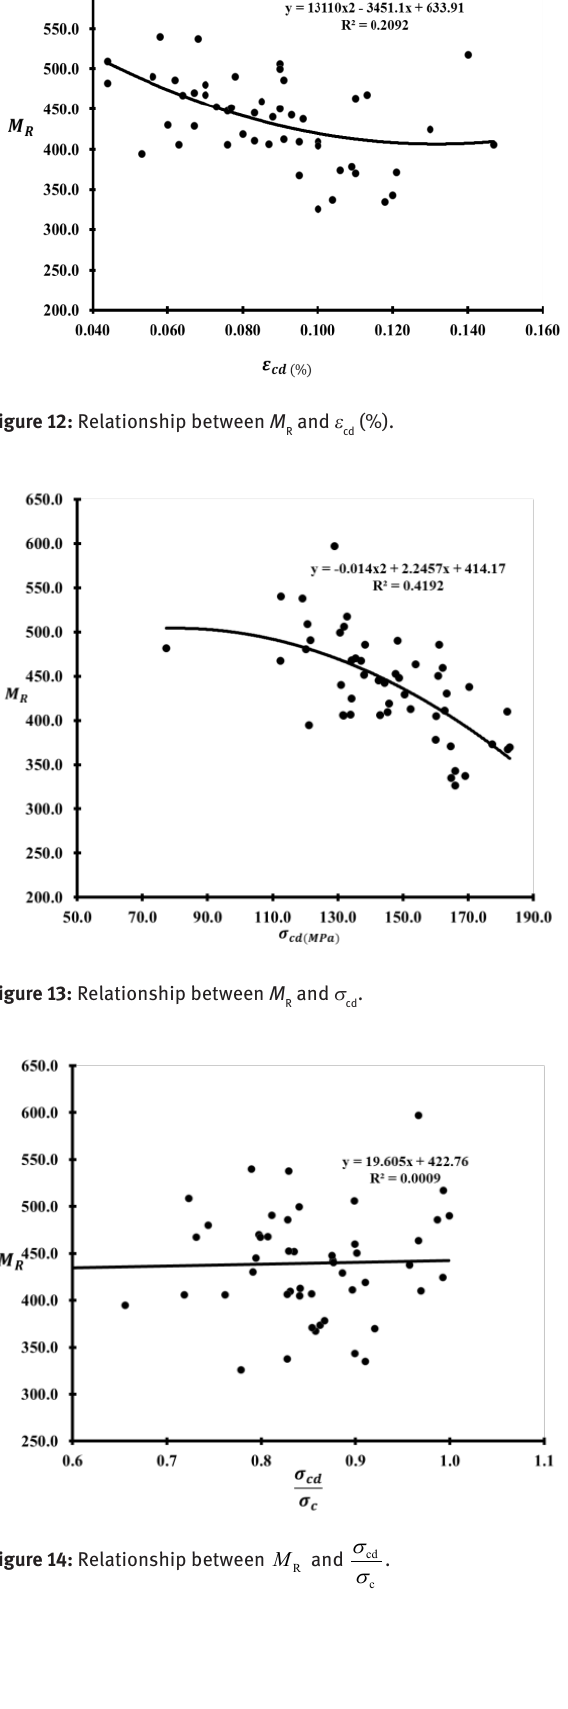
Fig. 14. Relationship between Fig. 16. Relationship between 𝜎𝜎 𝑐𝑐𝑐𝑐 𝜎𝜎 𝑐𝑐 and 𝜀𝜀 𝑎𝑎 (cid:3) 𝑚𝑚𝑎𝑎𝑚𝑚 𝜀𝜀 𝑐𝑐𝑐𝑐 Fig .17. Relationship between 𝑀𝑀 𝑅𝑅 and crack initiation stress( 𝜎𝜎 𝑐𝑐𝑐𝑐 )